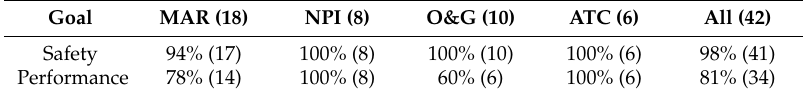
Table 2. Percentage (number) of papers that mention the specified organisational goal per industry.